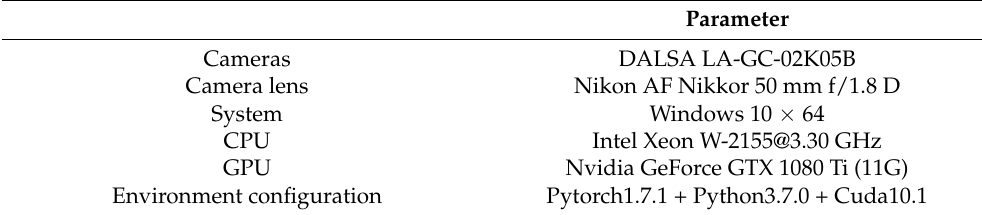
Figure 1. Image acquisition equipment for sawn timber. Table 1. Software and Hardware Environment Configurations.